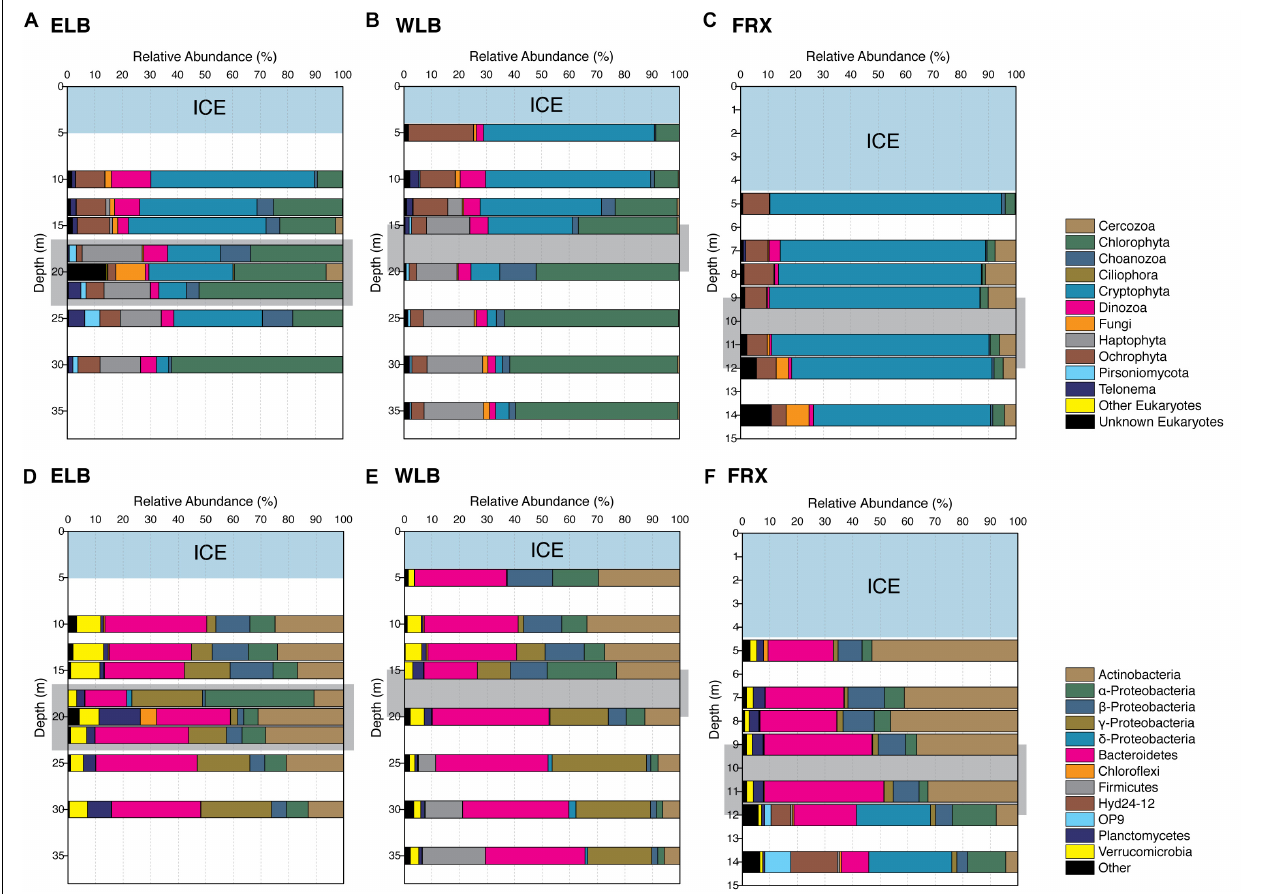
FIGURE 3 | Diversity of Eukarya (A–C) and Bacteria (D–F) in the east and west lobes of Lake Bonney (ELB and WLB, respectively) and Lake Fryxell (FRX). The counts of OTUs based on 16S and 18S rRNA gene sequences are binned to phylum level, except for Proteobacteria which are shown in families. Light blue shows perennial ice covers and light gray indicates the permanent chemoclines in each